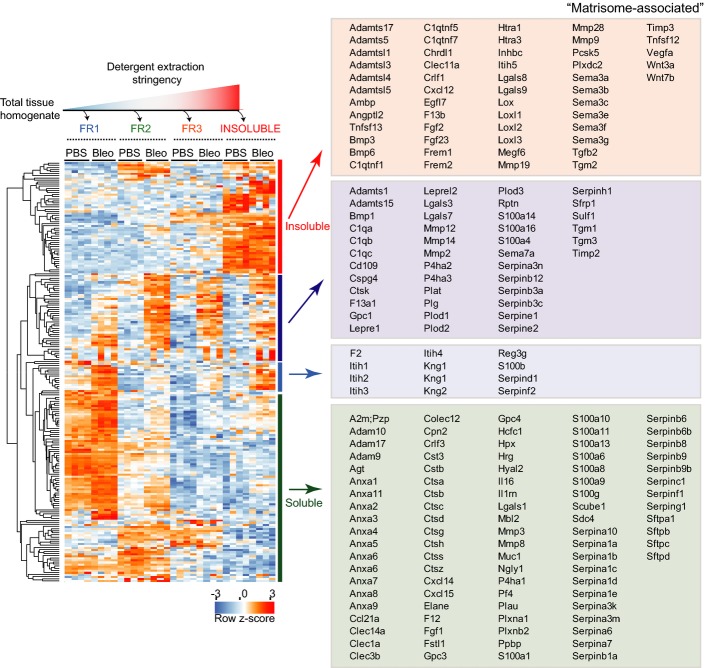
Assignment of secreted proteins to the extracellular matrix niche in vivoProteins annotated with the term “matrisome-associated” (Naba et al, 2012a) were grouped using unsupervised hierarchical clustering of the z-scored MS intensities across the indicated experimental groups and protein fractions. Gene names within individual clusters are shown in boxes in the right panel.